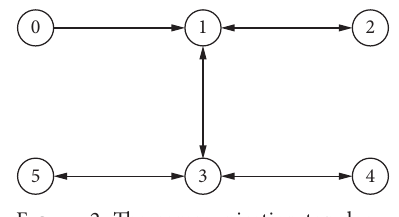
Figure 2: The communication